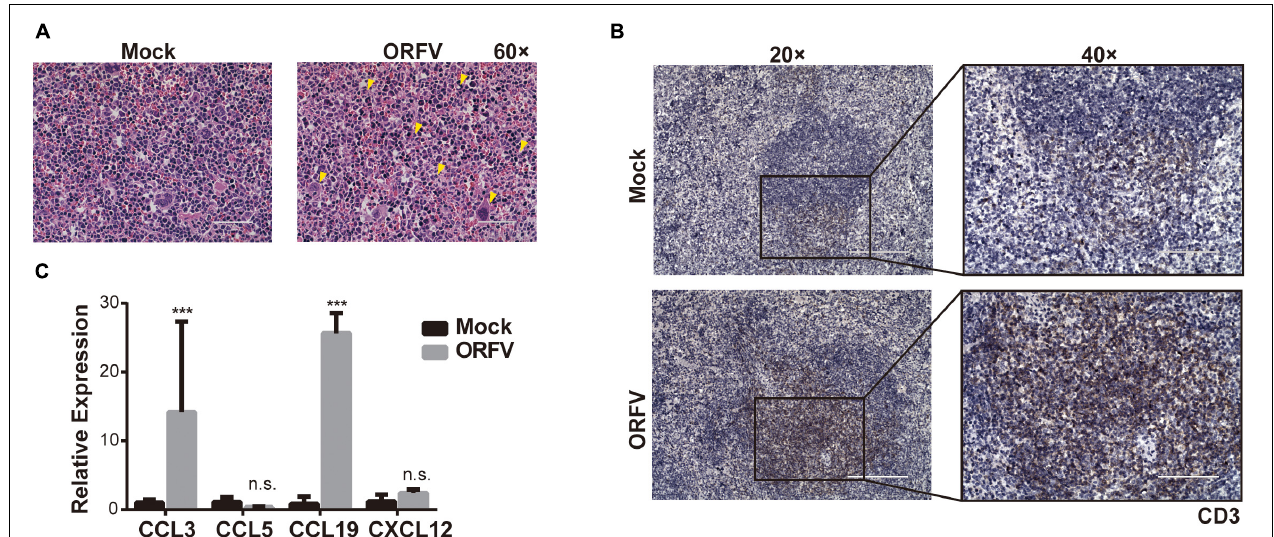
FIGURE 4 | ORFV activates the anti-tumor effect of host immunity. (A) Representative images of the spleen by HE staining. Neutrophils and secondary follicles are represented by yellow triangular markers. (B) Representative IHC results of CD3 expression in spleen. (C) qPCR analyses of cytokines levels (CCL3, CCL5, CCL19, and CXCL12) in tumor tissue were treated with PBS or ORFV. The results are expressed as the means ± SEM of three independent experiments. n.s., p > 0.05; *** p < 0.001.